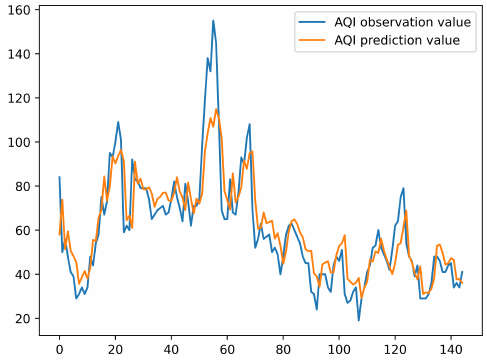
Figure 3. LSTM air quality index prediction results.